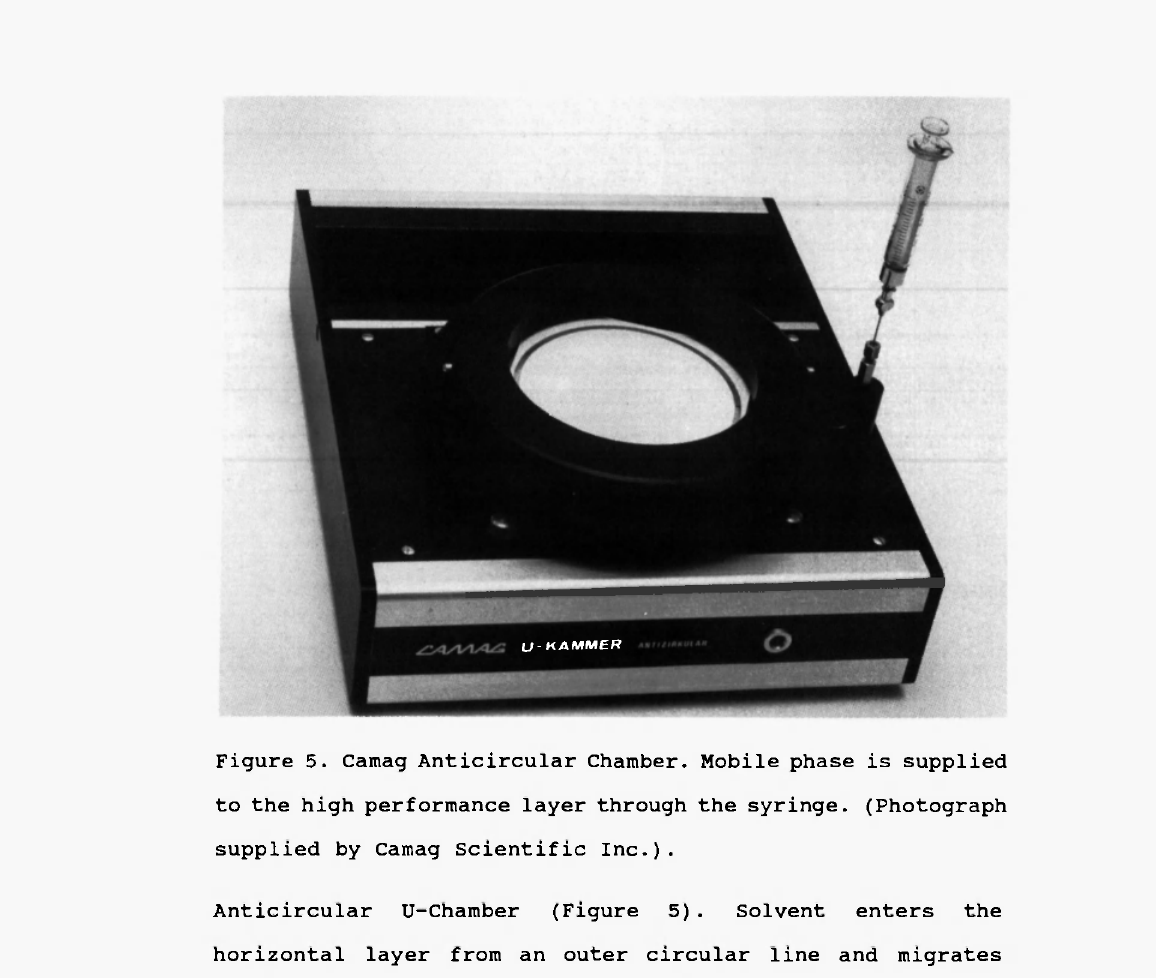
Figure 5. Camag Anticircular Chamber. Mobile phase is supplied to the high performance layer through the syringe. (Photograph supplied by Camag Scientific Inc.). (Figure 5). enters